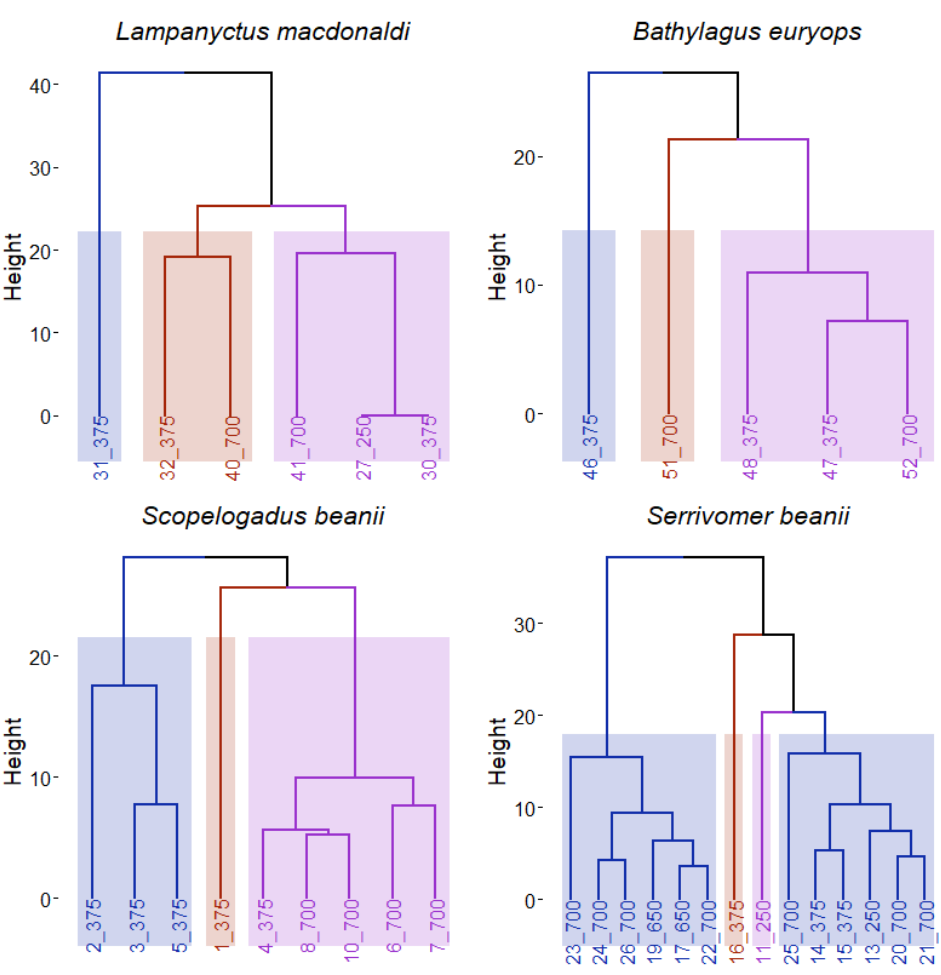
Figure 10. Cluster analysis of the muscle-tissue fatty acid composition in mesopelagic fish species ( Bathylagus euryops , Lampanyctus macdonaldi , Scopelogadus beanii , Serrivomer beanii ) living at different depths in the Irminger Sea (North Atlantic).